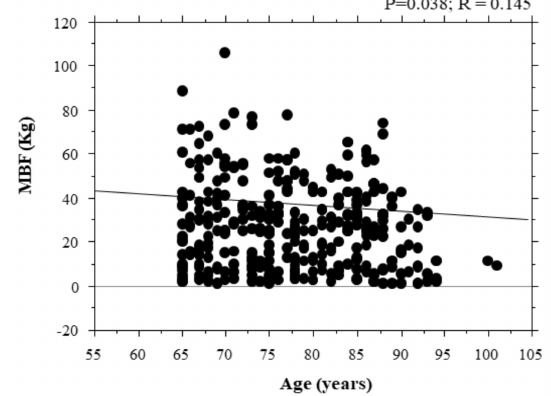
Figure 4. Correction of bite force with age. Correlations of maximal bite force with age of the subjects. MBF: maximal bite force; R = coefficient of correlation; P = p -value ( p ).